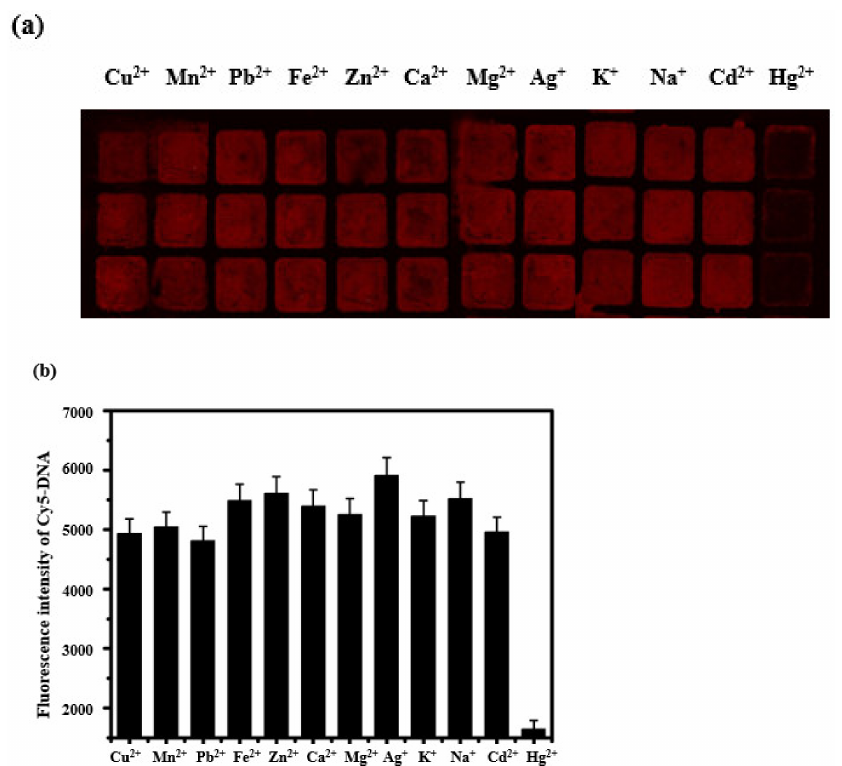
Figure 4. Selectivity analysis for Hg 2+ detection based on sensors containing DNA sequence II hybrid with two PS cutting sites. ( a ) Scanning image of the chip microarray after adding various metal ions. ( b ) The fluorescence intensity of the Cy 5-DNA in the presence of different metal ions. Each concentration of the metal ion was fixed at 1 µ M.